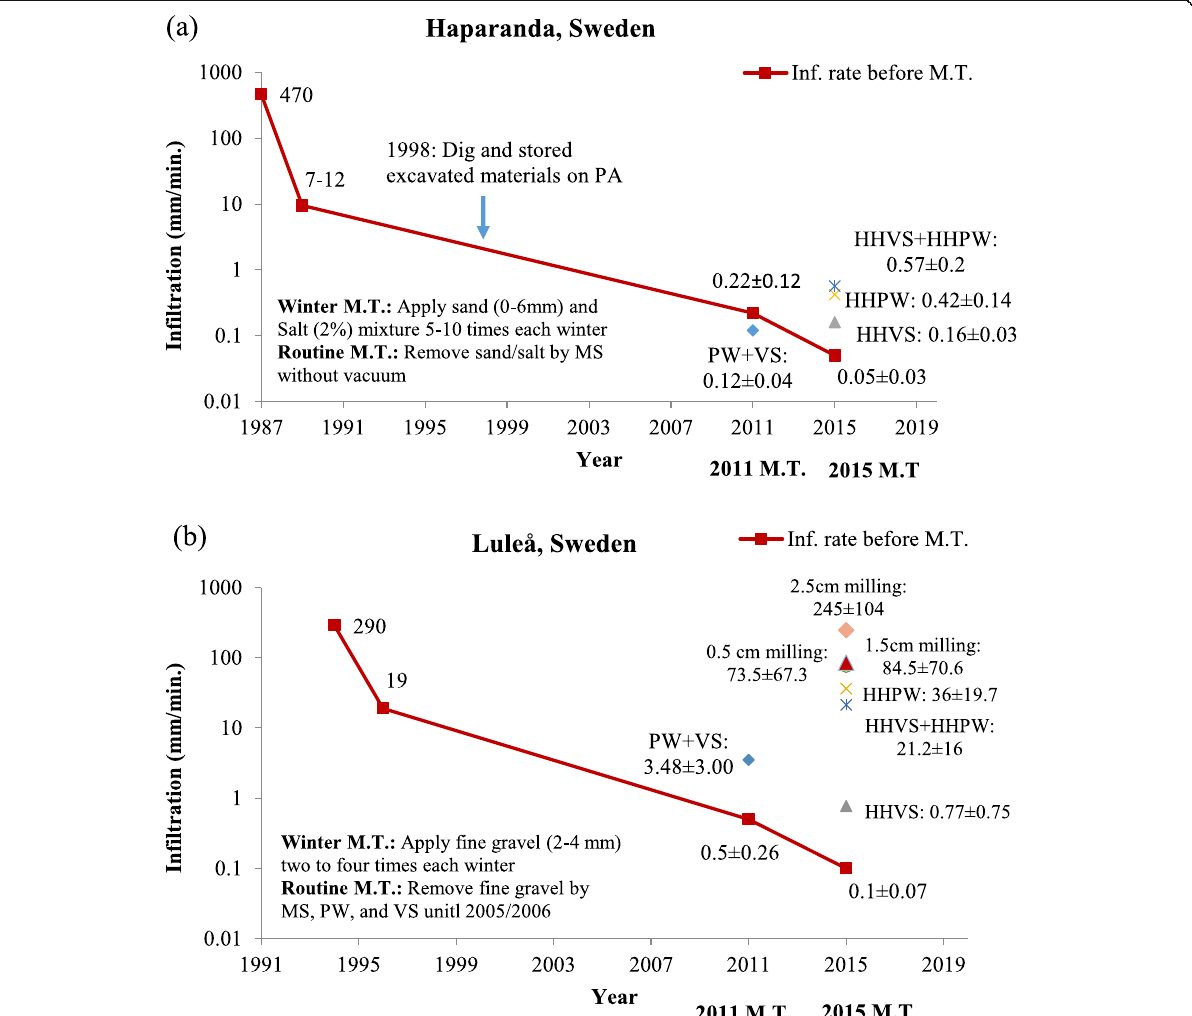
Fig. 3 Long-term infiltration rate and restorative maintenance for porous asphalt pavements at ( a ) Haparanda, Sweden [2, 66] and ( b ) Luleå, Sweden [2, 8, 56, 66]. (Acronym: Inf. = infiltration; M.T. = maintenance; MS = mechanical sweeping; PW = pressure washing; VS = vacuum sweeping; HHVS = hand-hold vacuum sweeping; HHPW = hand-hold pressure